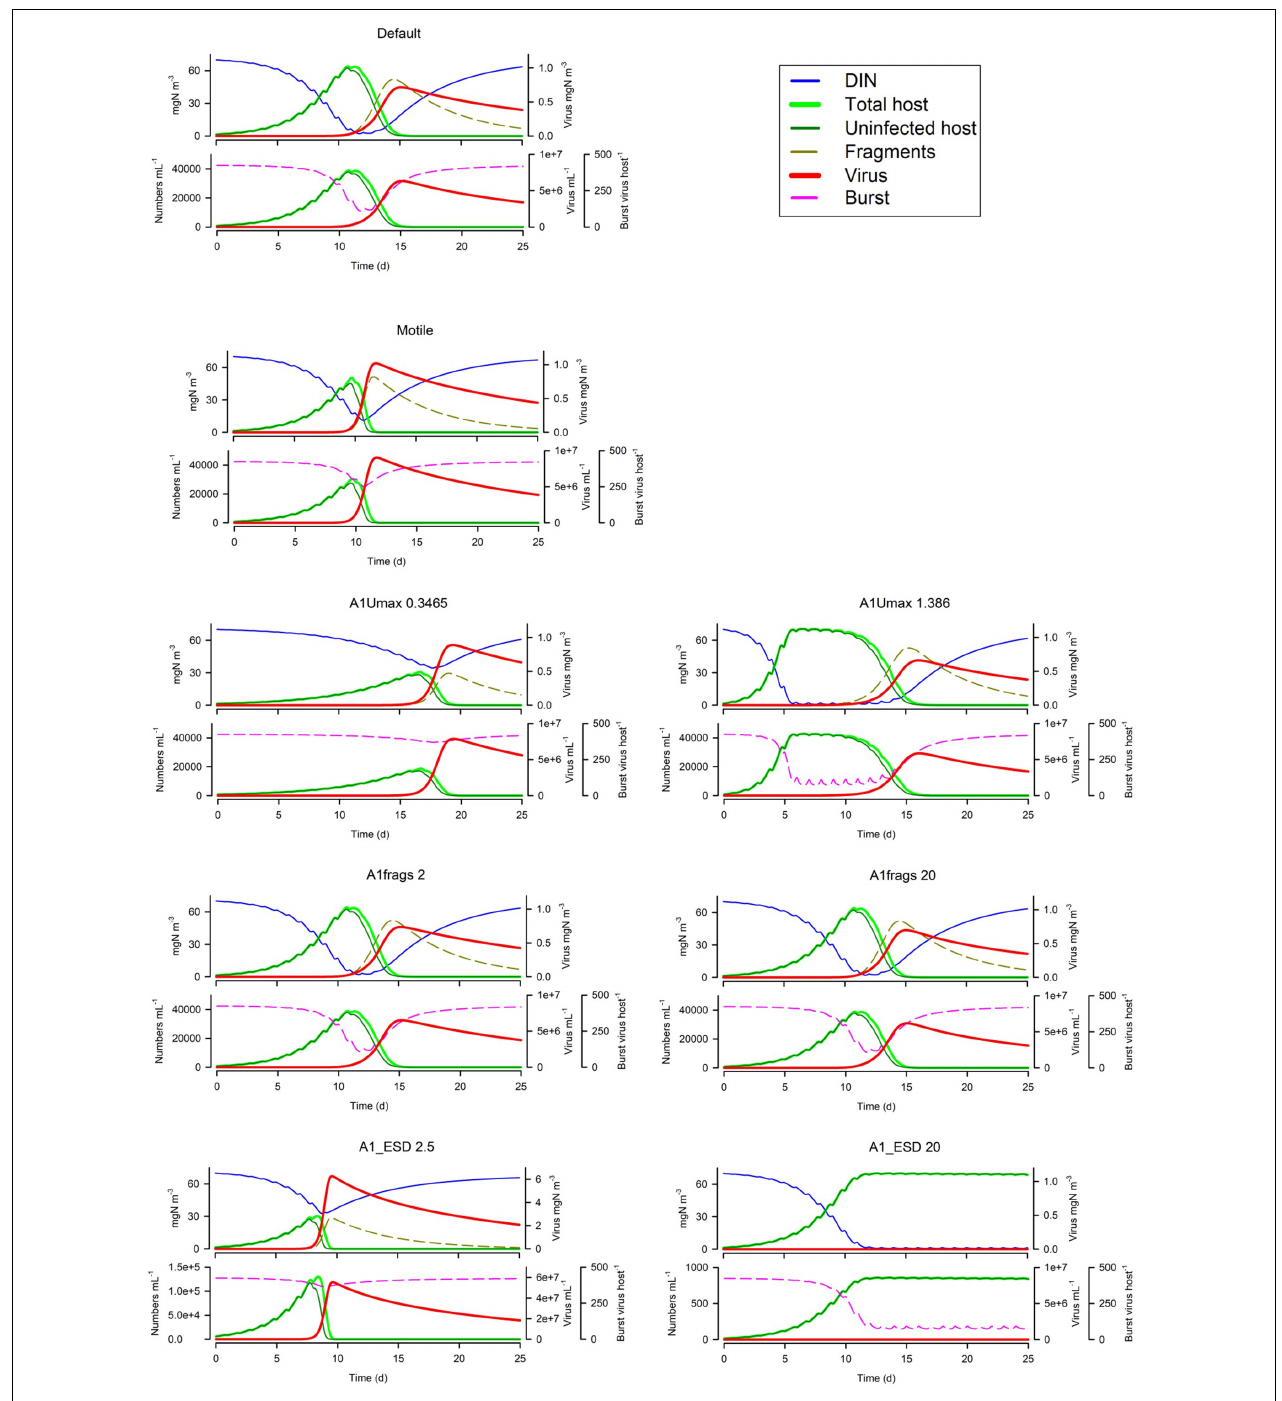
FIGURE 6 | Effects of host motility (the Default being non-motile), host maximum growth rate (0.3486 or 1.388 d − 1 vs Default of 0.693 d − 1 ), fragment count on lysis (2 or 20 host − 1 vs Default of 10 host − 1 ), host ESD (2.5 µ m or 20 µ m vs Default of 5 µ m) with fixed virus maximum burst size. The Default ( Figure 1B ) is reproduced in the top left-hand corner. See also Table 5